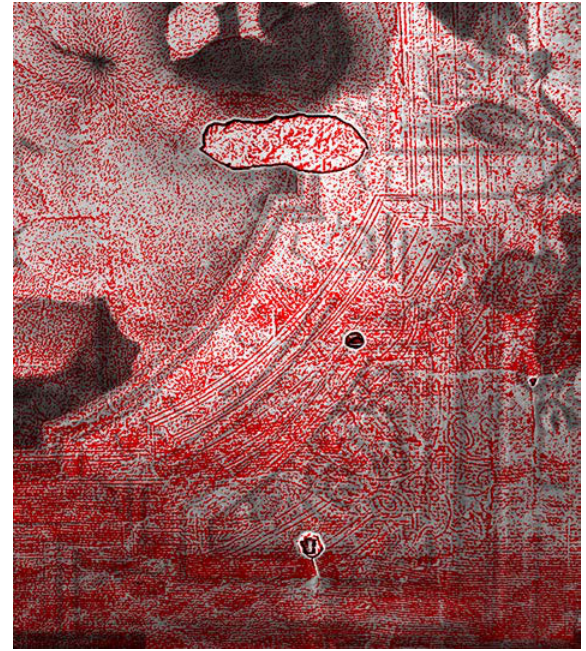
Figure 4. The mesh model showing a sketch scratched on the plaster different from the painting (image processed with Adobe Photoshop’s edge enhancement